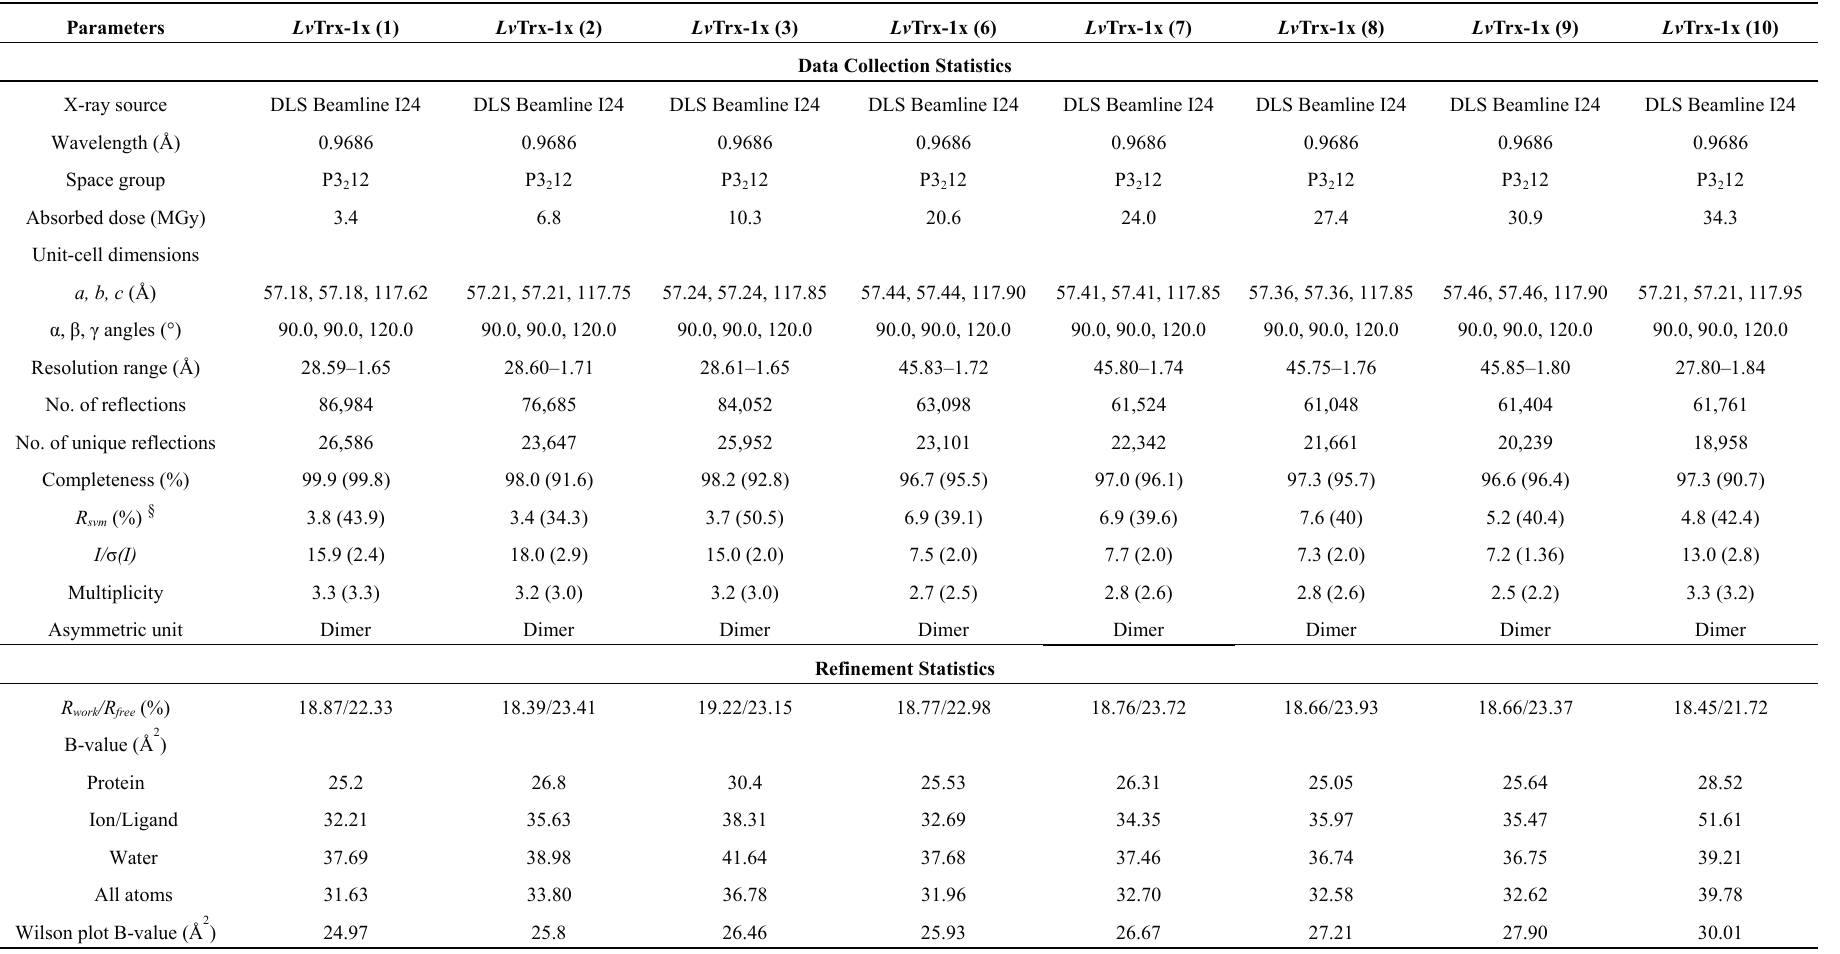
Table 1. Summary of crystallographic data of Lv Trx-1x. Values in parentheses are for the highest resolution